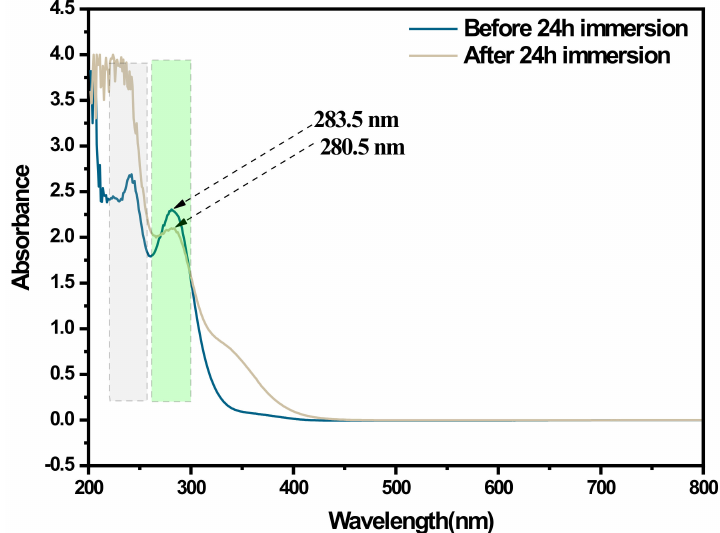
Figure 7. UV-visible plots of CHA extract in 1 M HCl medium before and after iron immersion at 298